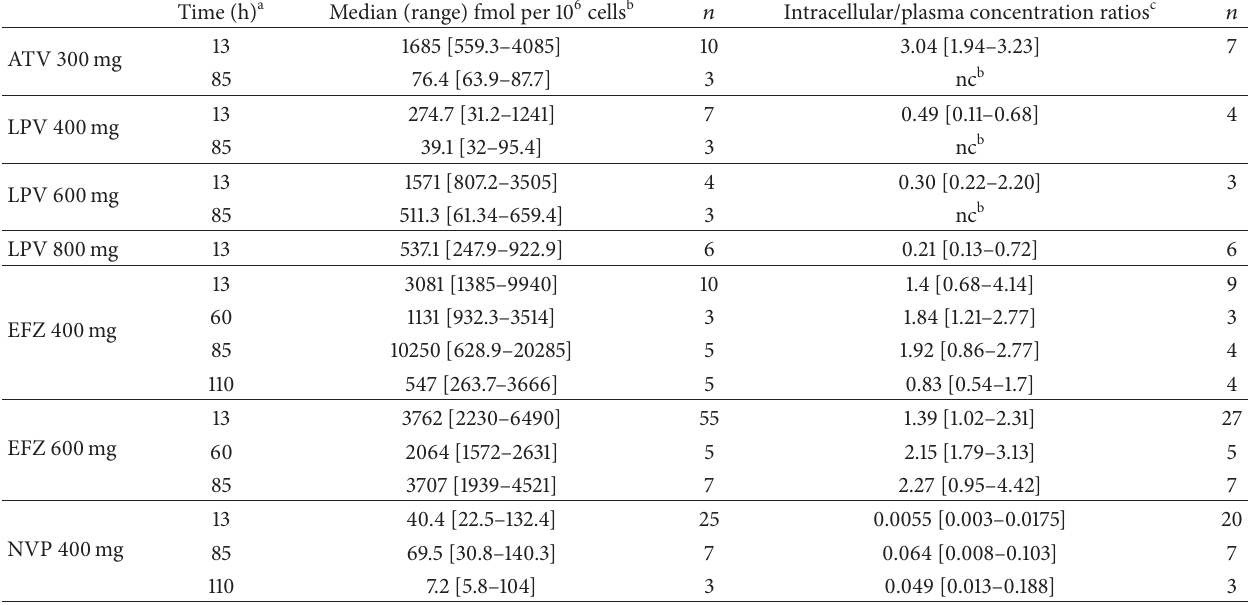
Table 1: Intracellular concentrations and intracellular/plasma concentration